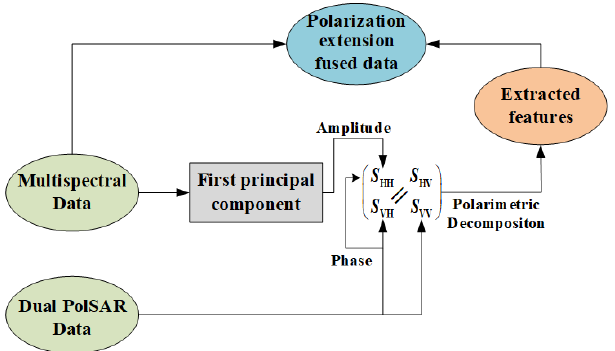
Figure 5. The generation process of polarization extension-fused data.